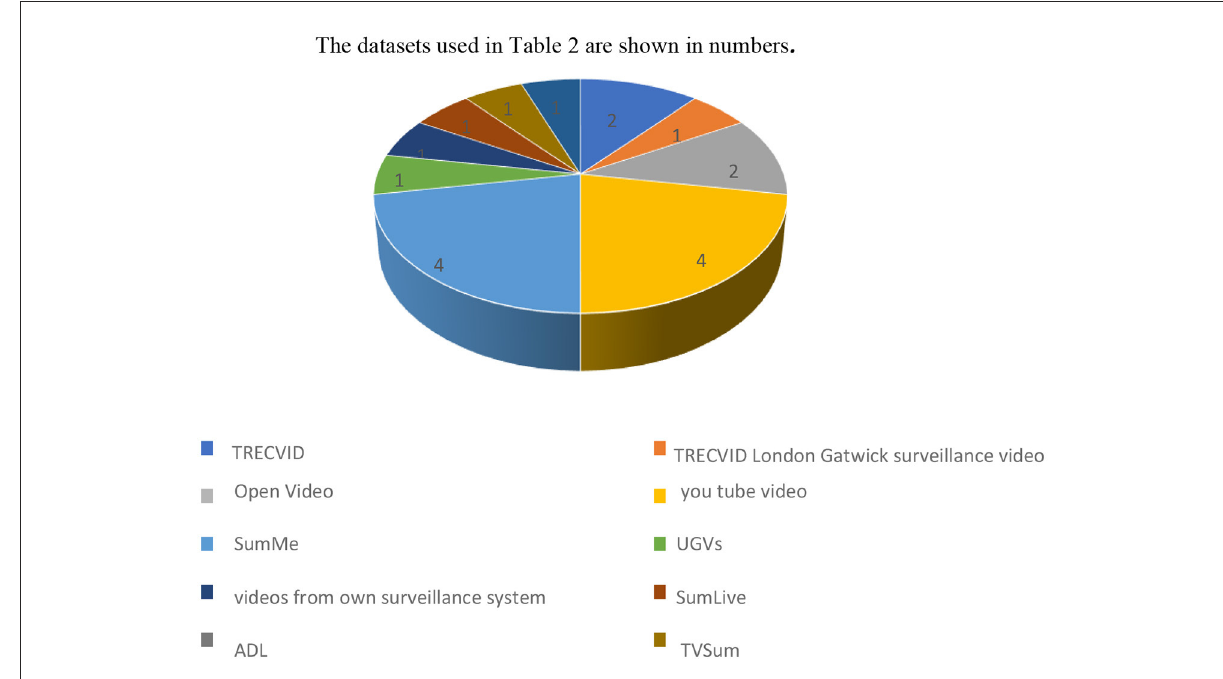
FIGURE7 Dataset used in real time